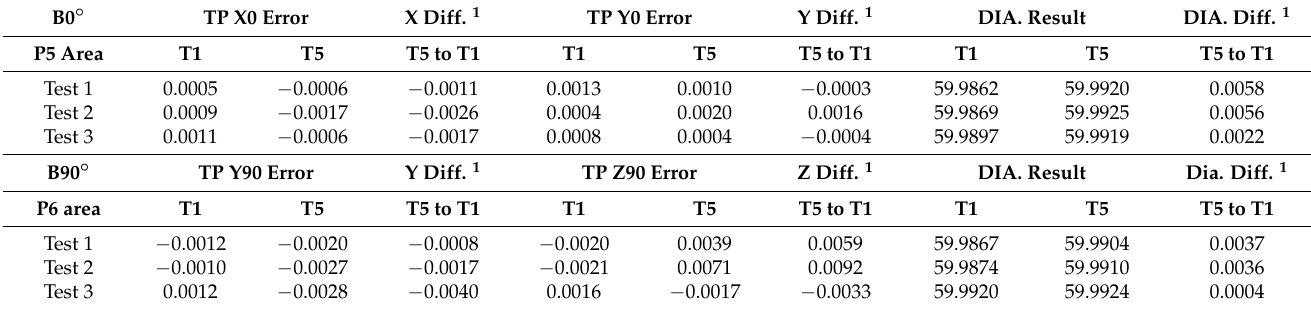
Table 11. T5 MC#2 probe results dispersion, and comparison to T1 probe, new styli and extension.